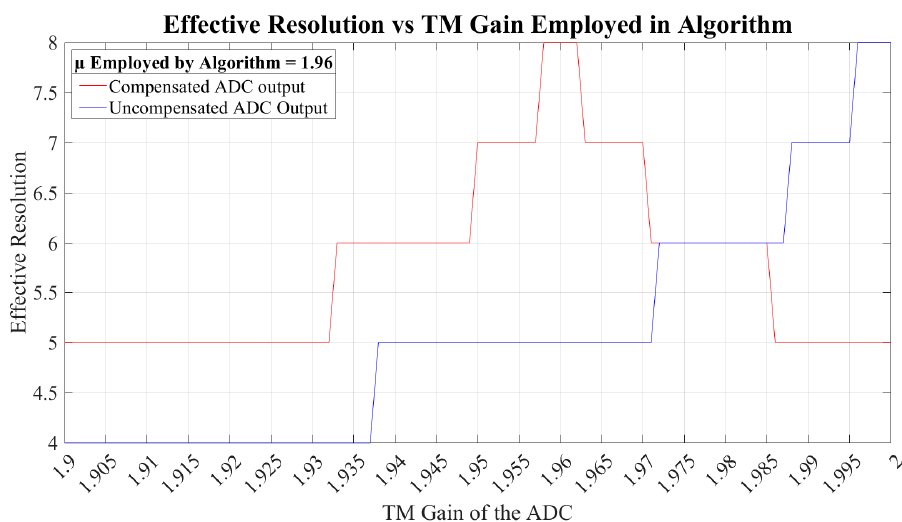
Figure 19. Sensitivity analysis results from an eight-stage TM-based ADC.